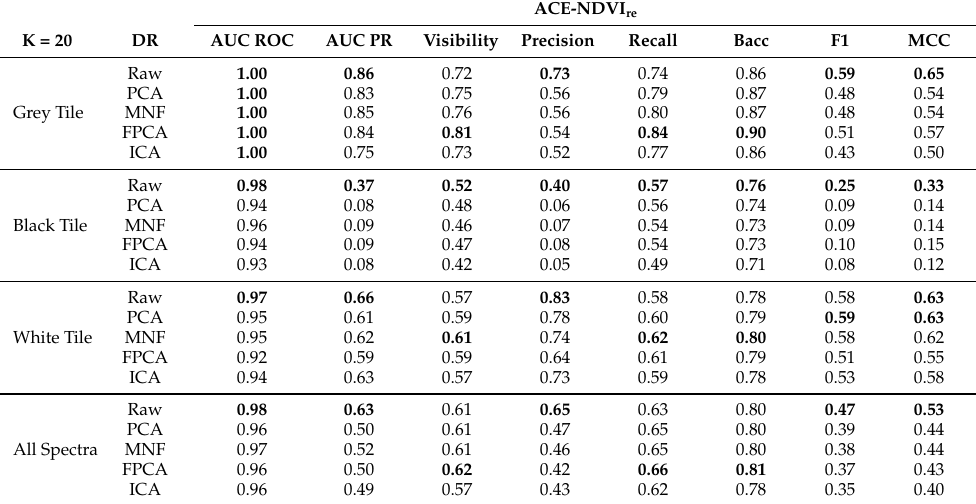
Table 6. Average performance measures for each target in the OP7 dataset with NDVI re -based spatial DR applied using the ACE